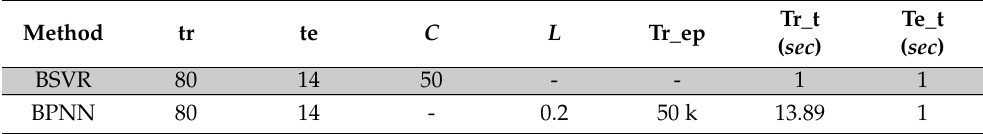
Table 8. Performance Comparison of BSVR and